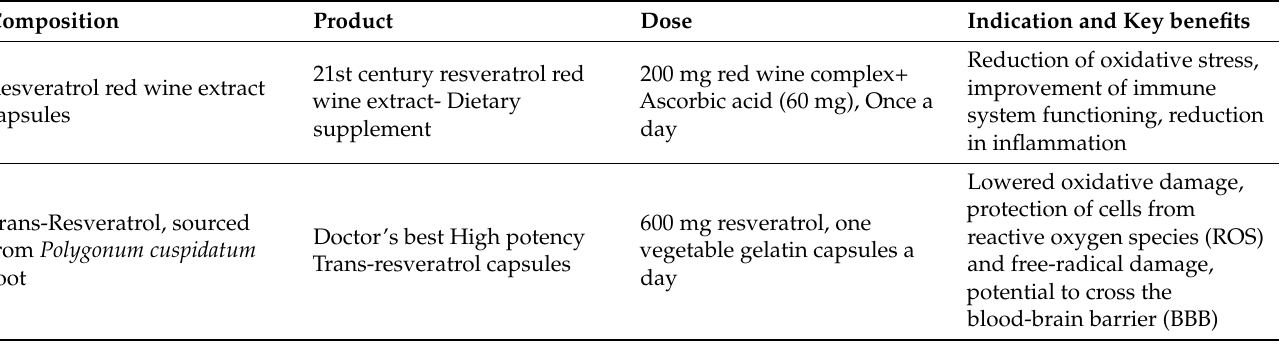
Table 3. Overview of the marketed formulations of resveratrol, along with their indications and